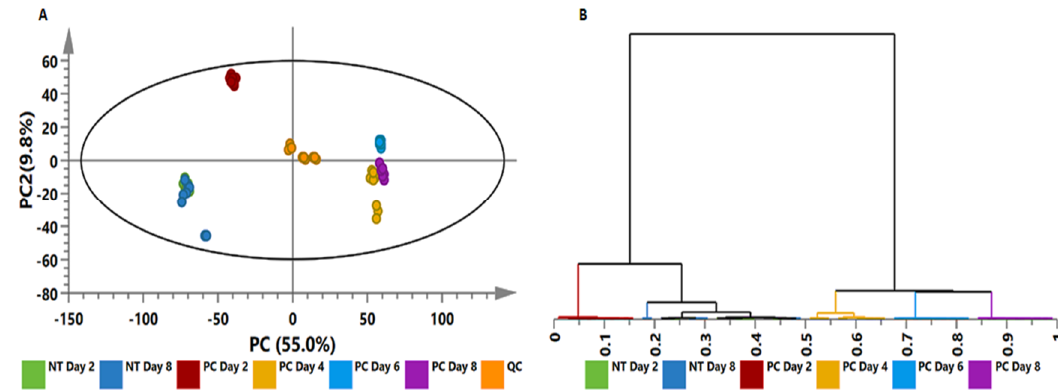
Figure 3. Unsupervised statistical analysis of tomato plants infected with Phytophthora capsici; leaf data acquired in electrospray ionisation (ESI − ) mode. ( A ): A principal component analysis (PCA) scores scatter plot of all the samples, including the quality control (QC) samples, coloured according to time points. The PCA model presented here was a 7-component model, with R 2 of 0.801 and Q 2 of 0.737. ( B ): The hierarchical clustering (HC) dendrogram corresponding to (A). Unsupervised statistical analysis was used to generate subgrouping of samples based on similar observations in (A), while the HC dendrogram shows the hierarchical relationship between samples (B). Similar figures (both for ESI − and ESI + modes) were generated for stem and root tissue and are presented as Figures S6A–S10A. NT = non-treated and PC = P. capsici -treated/stem inoculated.